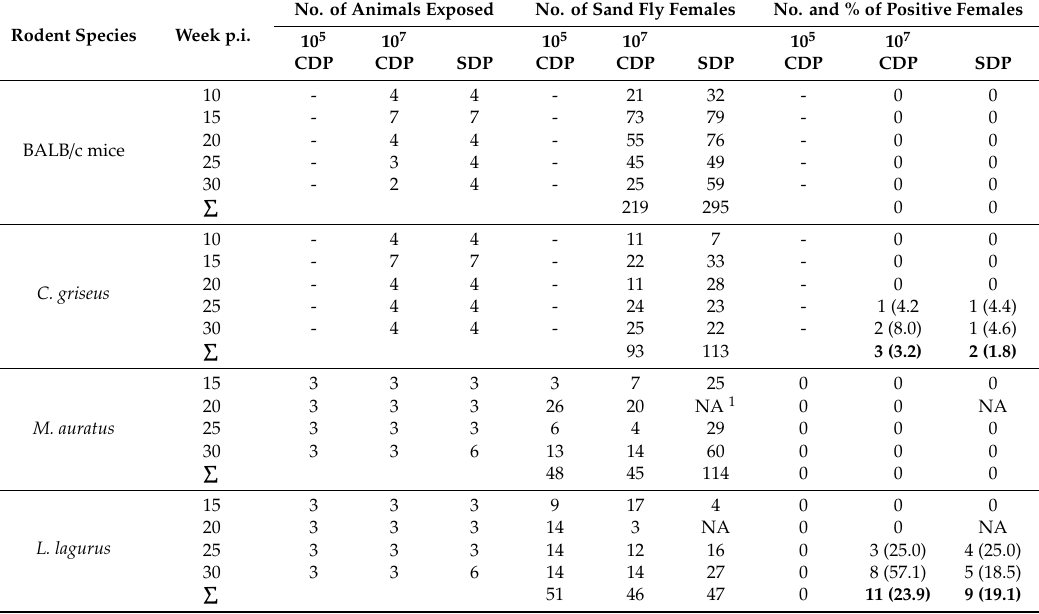
Table 3. Results of xenodiagnosis experiments performed with P. orientalis in the four rodent species infected with L. donovani .